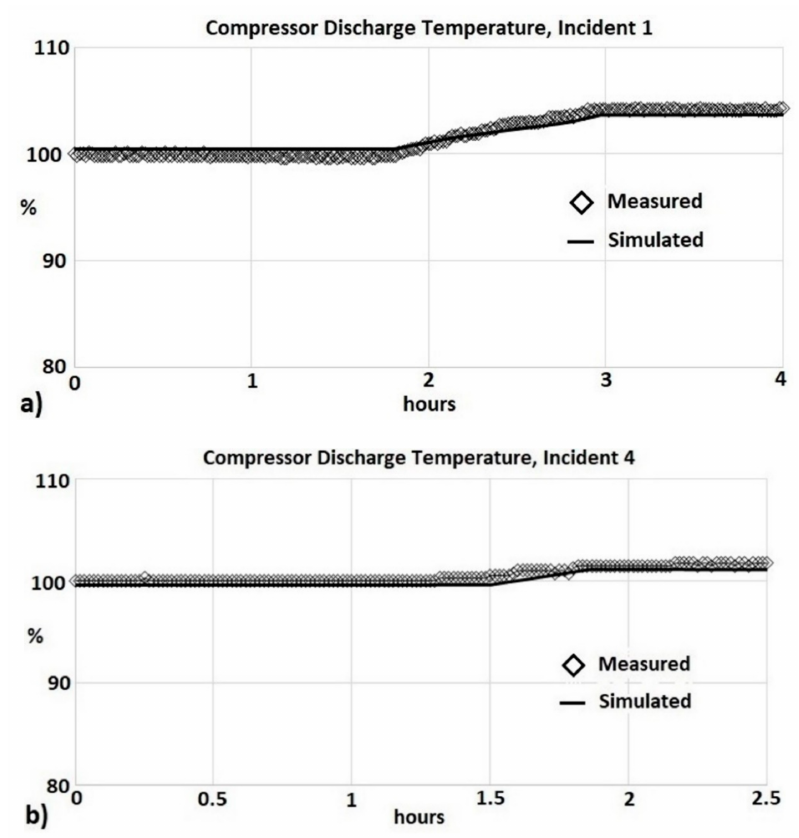
Figure 21. Measured and simulated compressor discharge temperatures: ( a ) Incident 1; ( b ) Incident